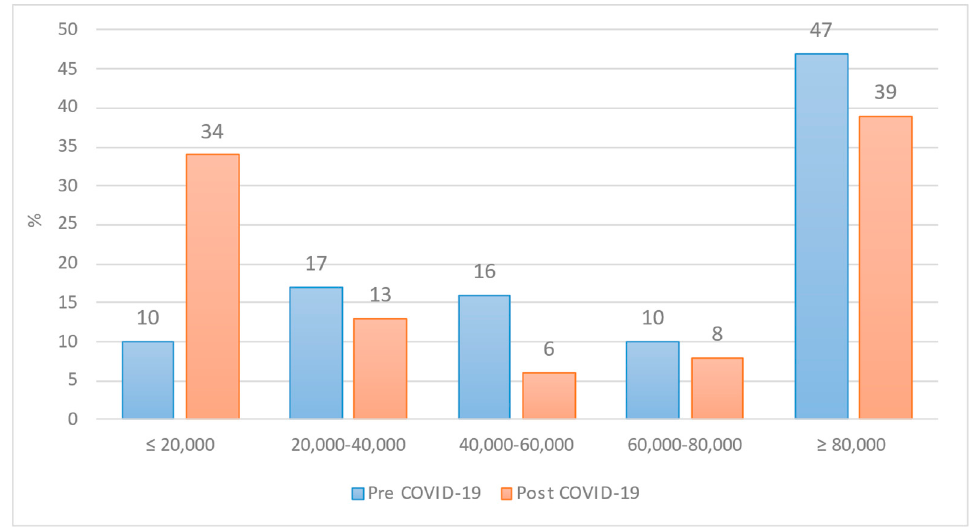
Figure 5. Incidence of gross turnover class (values in %) (author: our elaboration). • Figure 7 —Perception of changes in the main tourism and hospitality activities (values in %) is not the correct one because you placed twice the Figure 8. Please replace it with the correct figure in the excel file here enclosed file.